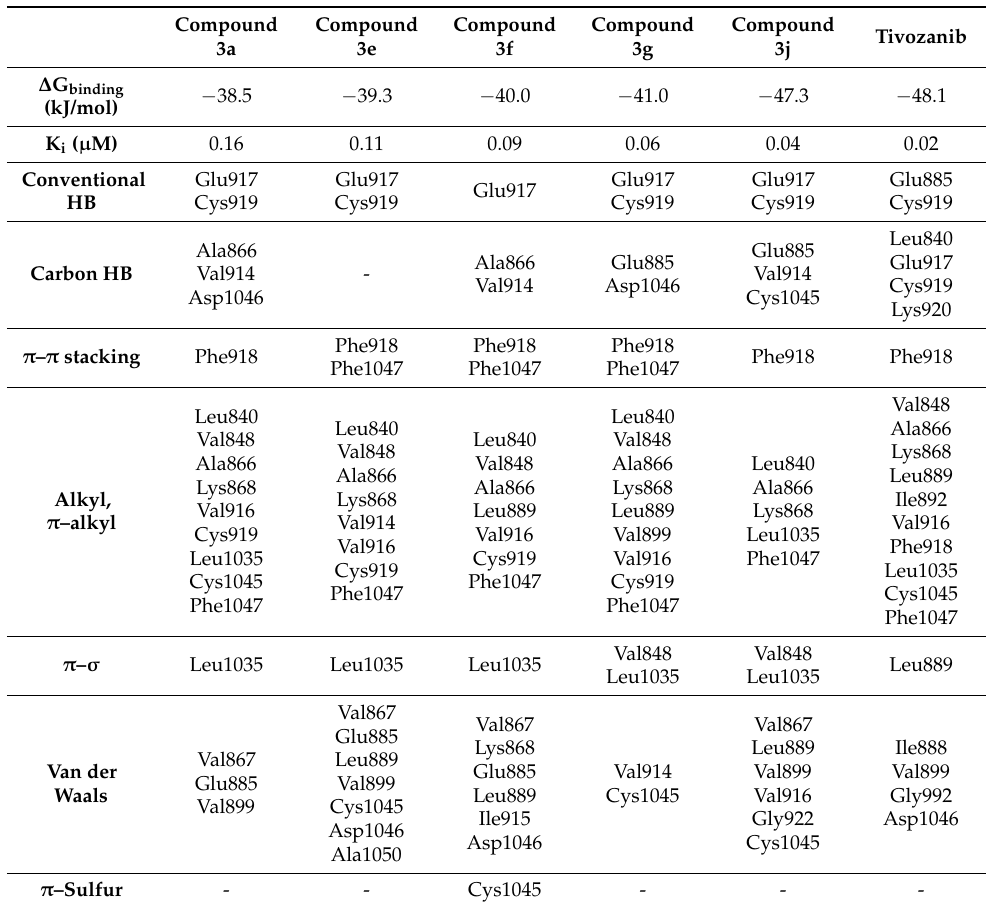
Table 3. The best docking conformations rated by scoring functions, including in terms of free energy of binding, inhibition constant, and intermolecular interaction observed during molecular docking to the active site of